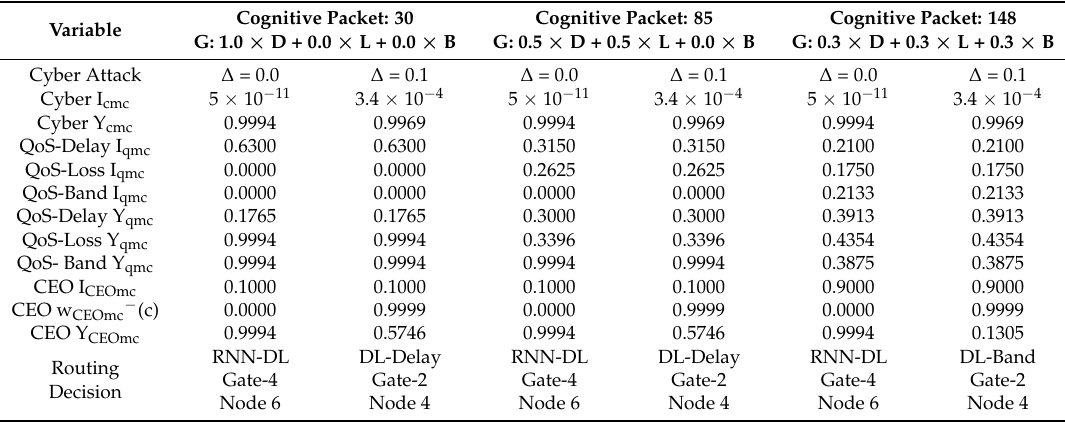
Table 9. DL Management Cluster Validation (3 × 3